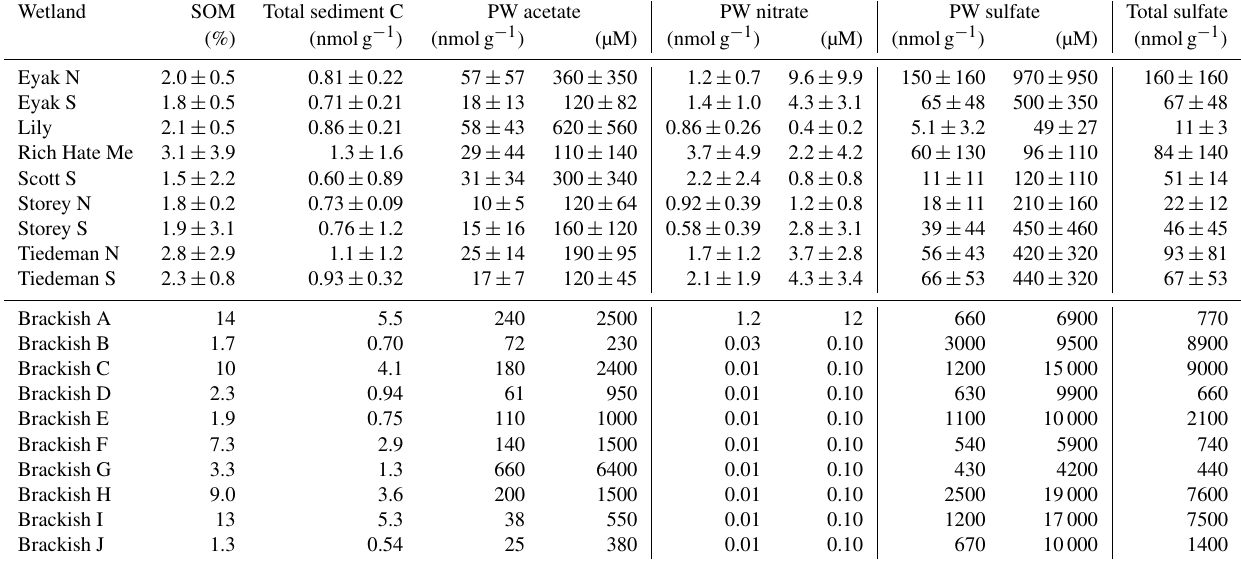
Table 2. Sediment chemical characteristics (mean ± SD) of the wetlands in the Copper River delta including sediment organic matter (SOM%), total sediment carbon, and porewater (PW) concentrations of acetate, nitrate, and sulfate as well as total sulfate availability in the slurry incubations. For the freshwater wetlands, measurements were conducted in June and August 2014 (5 sites × 2 time periods, n = 10 per wetland). For the brackish wetlands, sediment chemistry is from one measurement only. Tidal brackish wetlands A–E were sampled in June and F–J were sampled in August. All chemistry parameters were converted to the total amount of anion per gram of dry sediment (nmolg − 1 ) for analyses, but standard porewater concentrations (µM) are also reported for comparison with other studies. Porewater nitrate concentrations were extremely low with many below what we considered our detection limit (i.e., <